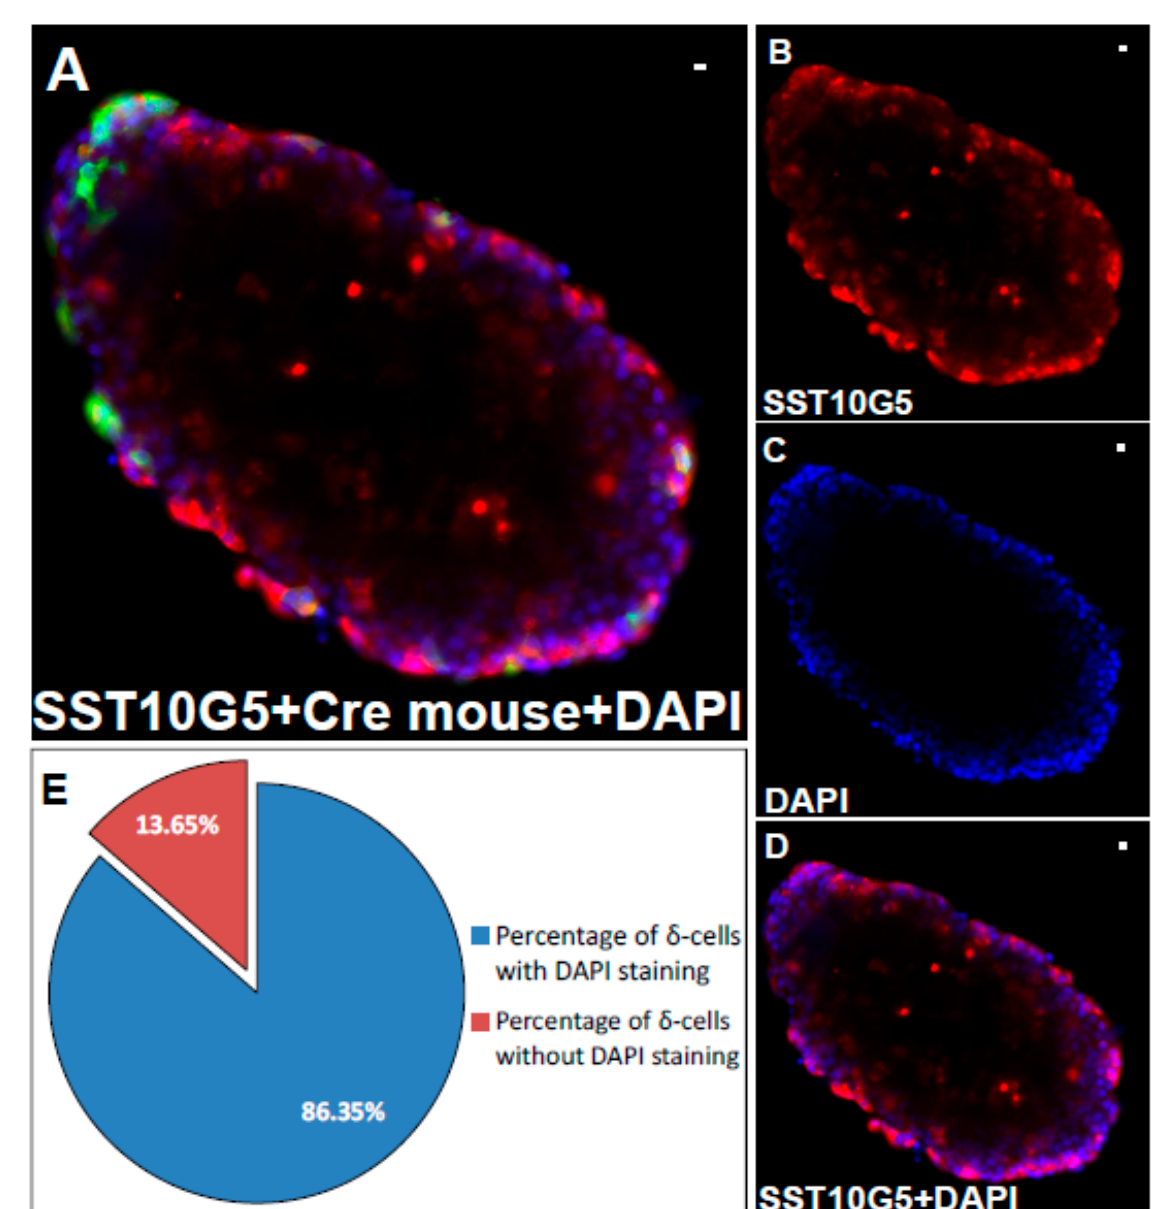
Figure 2. Immunostained δ -cells counterstained with nuclear stain DAPI—( A ) Islets from SST-iCre mice labelled with δ -cell specific antibody SST10G5 counterstained with nuclear stain DAPI (Scale bar = 10 µ m), ( B ) Immunostained islets in ( A ) showing the SST10G5 δ -cell labelling (Scale bar = 10 µ m), ( C ) Immunostained islets in ( A ) showing the DAPI staining (Scale bar = 10 µ m), ( D ) Im- munostained islets in ( A ) showing the merged image with SST10G5 and DAPI (Scale bar = 10 µ m), ( E ) Pie chart showing the quantification of the SST10G5 δ -cells labelled cells conterstained with DAPI nuclear stain. (The SST10G5 antibody is in red, DAPI is in blue, transgenically labelled δ -cells in green.).